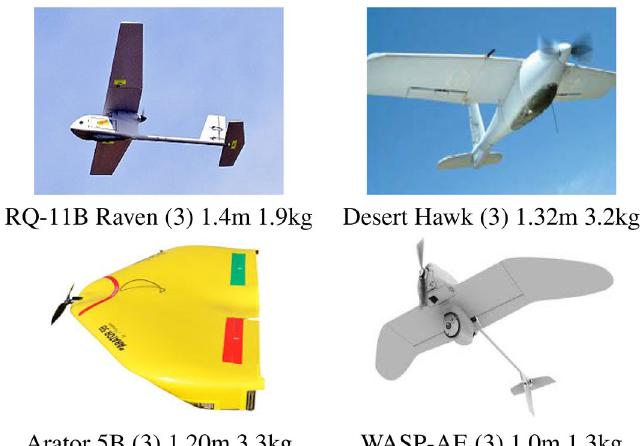
Figure 2. Main fixed wing UAV systems considered as very small (3) in the current work.